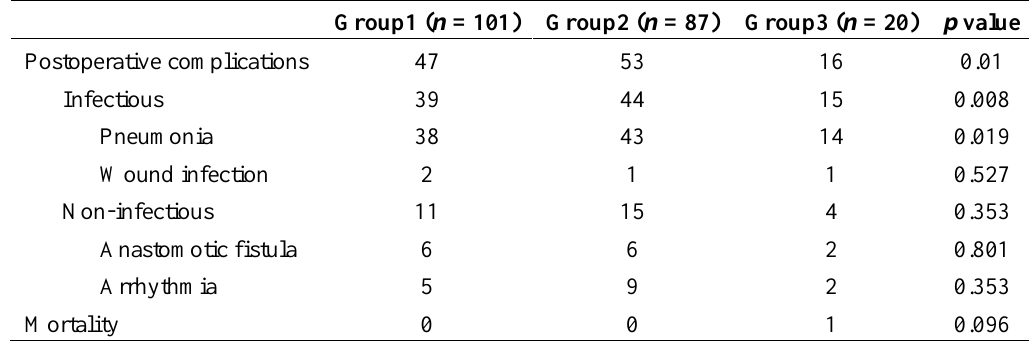
Table 2. Postoperative complications and mortality.